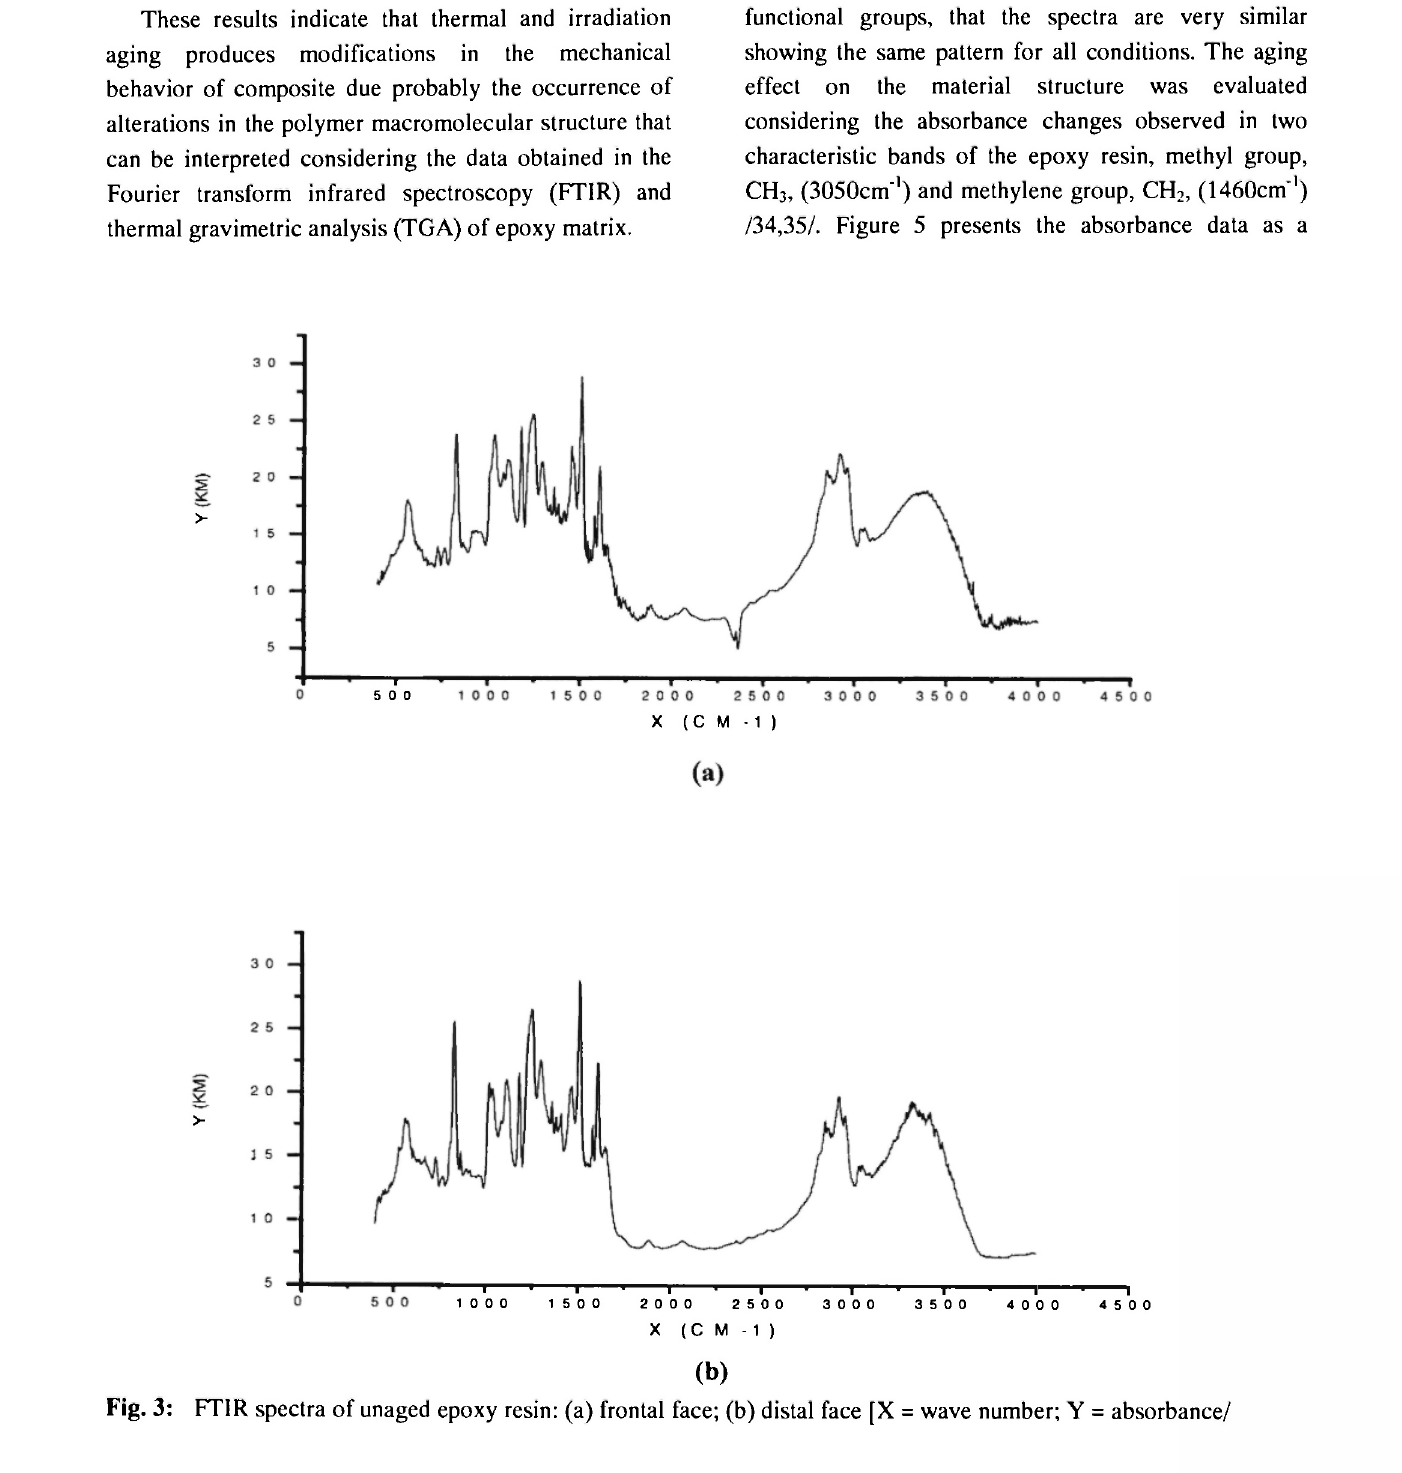
Fig. 3: FTIR spectra of unaged epoxy resin: (a) frontal face; (b) distal face [X = wave number; Y =